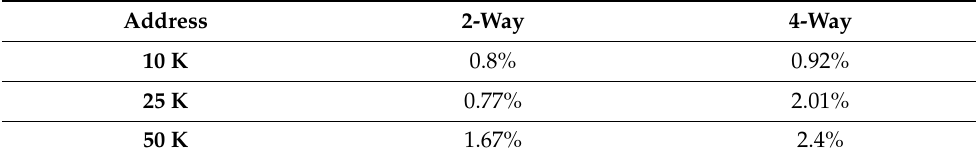
Table 7. Hit rate improvement in direct mapping with respect to time.